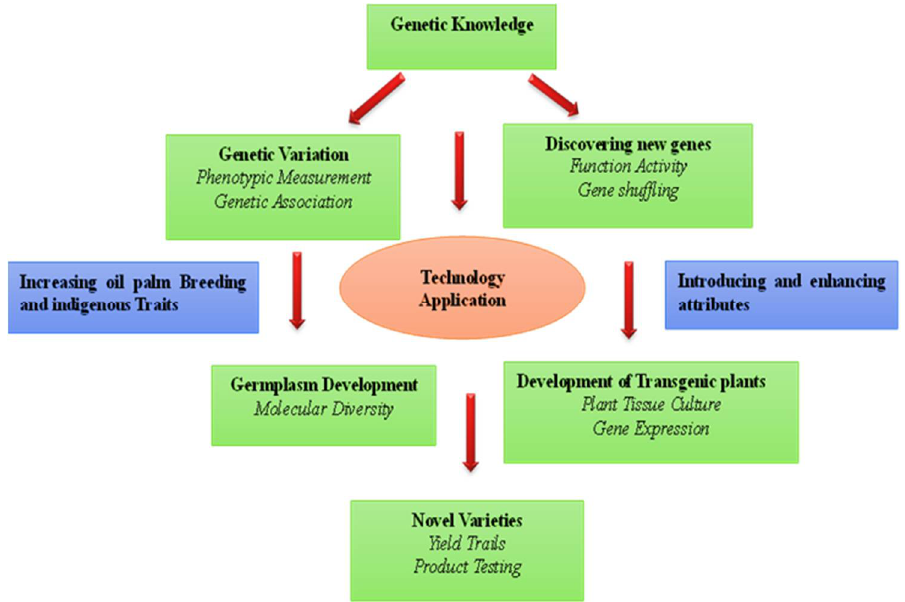
Figure 1. Tools for oil palm breeding. The left side exhibits the identification of native traits and molecular isolation of genes that reside in the oil palm, although sometimes in wild variants or in low-yielding varieties. The right side depicts discovery of transgenic traits, where we want to change the expression levels, location, or timing of a gene, or to use a gene from a different species.